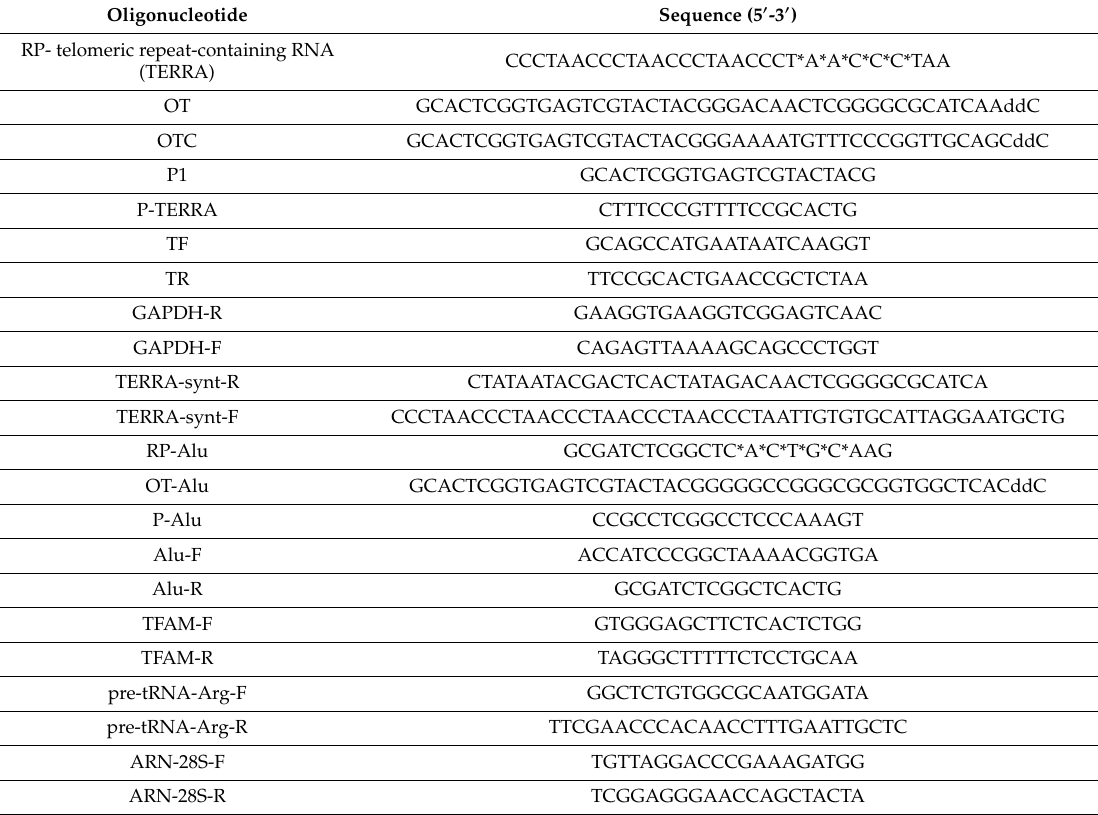
Table 1. Oligonucleotide sequences. Oligonucleotide Sequence (5 (cid:48) -3 (cid:48) ) RP- telomeric repeat-containing RNA